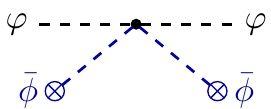
Figure 3 . A representative interaction between a small perturbation ’ and the background scalar condensate (cid:22) (cid:30) in which it is propagating. As shown in the text, in a theory where this interac- tion is mediated by a term c ( @(cid:30) ) 4 , unless c > 0, these interactions will lead to the superluminal propagation of ’